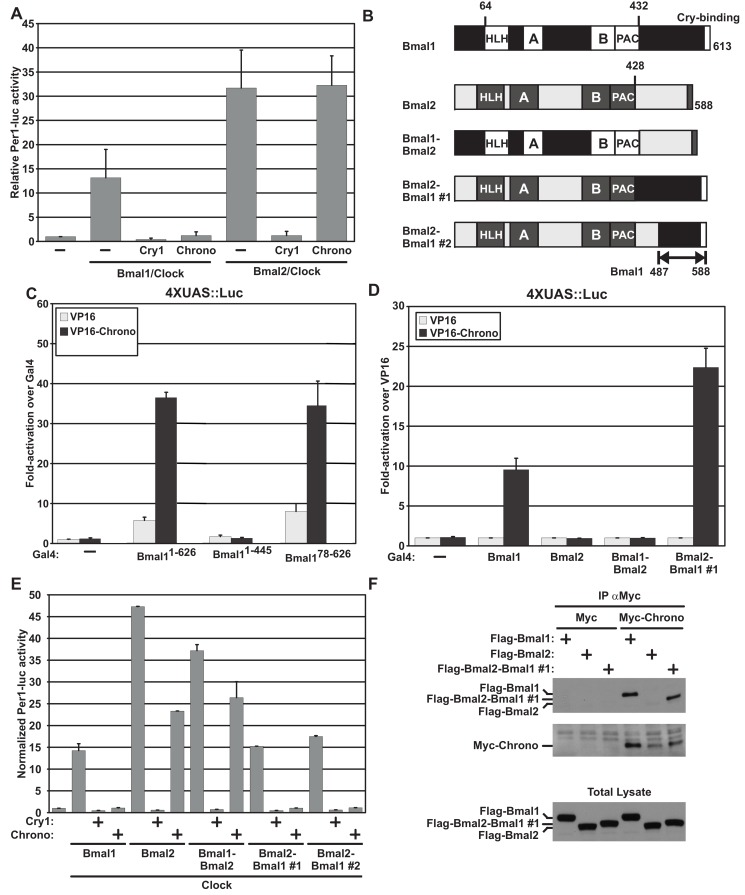
CHRONO interacts with the C-terminus of BMAL1 but not BMAL2.(A) Overexpression of either BMAL1 or BMAL2, along with CLOCK, activates Per1:Luciferase reporter activity. Both are repressed by overexpression of CRY1. CHRONO specifically represses BMAL1-induced reporter activity. (B) BMAL1 and BMAL2 have similar structures with conserved bHLH DNA binding domains and PAS A and B interaction domains. BMAL1 contains a unique C-terminal region. Chimeric proteins were constructed by swapping corresponding domains from each protein as shown. Two-hybrid screening in HEK 293T cells demonstrates that BMAL1 truncation mutants (C) and chimeric proteins (D) that contain the 487–586 region of BMAL1 bind CHRONO and induce UAS:Luc reporter expression. This region is adjacent to but distinct from the annotated CRY1 binding site. (E) All BMAL1–BMAL2 constructs induce Per1-luc reporter activity in HEK 293T cells. In all constructs, reporter signal is repressed by the addition of CRY1. Functional repression by CHRONO is limited to BMAL constructs containing the implicated binding domain. (F) In cells overexpressing MYC–CHRONO along with BMAL1, BMAL2, or a chimeric BMAL2–BMAL1 construct, co-IP confirms complex formation between CHRONO and proteins containing the implicated BMAL1 C-terminal region.